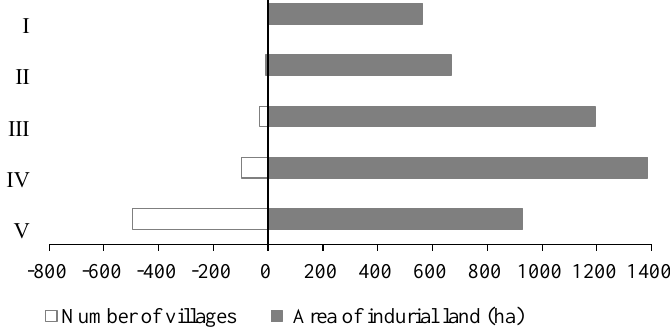
Figure 4. Number of villages and area of industrial land in five groups.